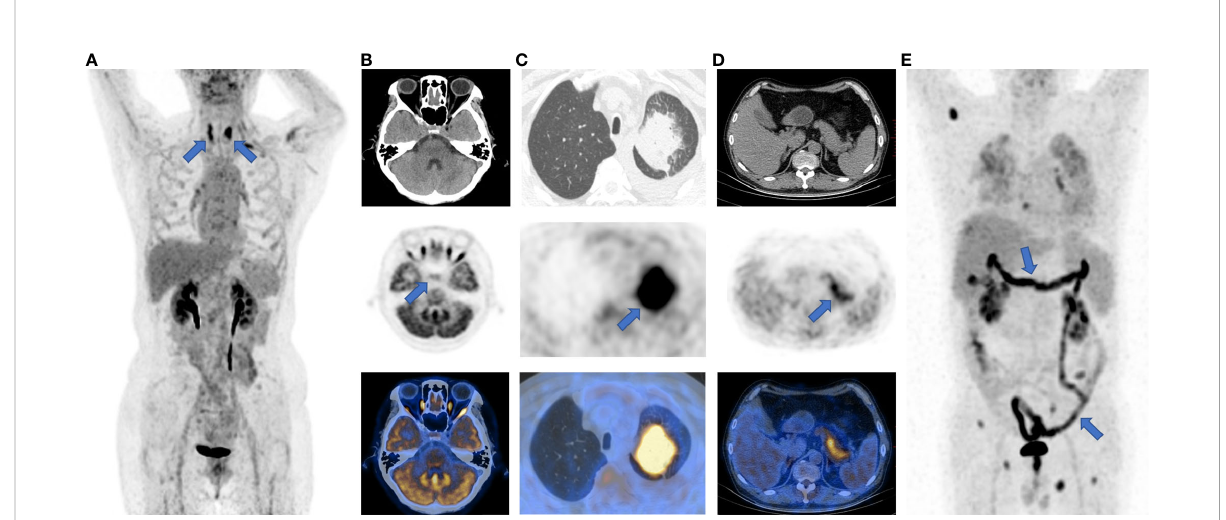
FIGURE 3 Typical images of irAEs in patients with ICI treatment. (A) , thyroiditis; (B) , hypophysitis; (C) , pneumonia; (D) , pancreatitis; (E) , enteritis. The sites of irAEs were marked with blue arrows on maximum intensity projection (MIP) and PET